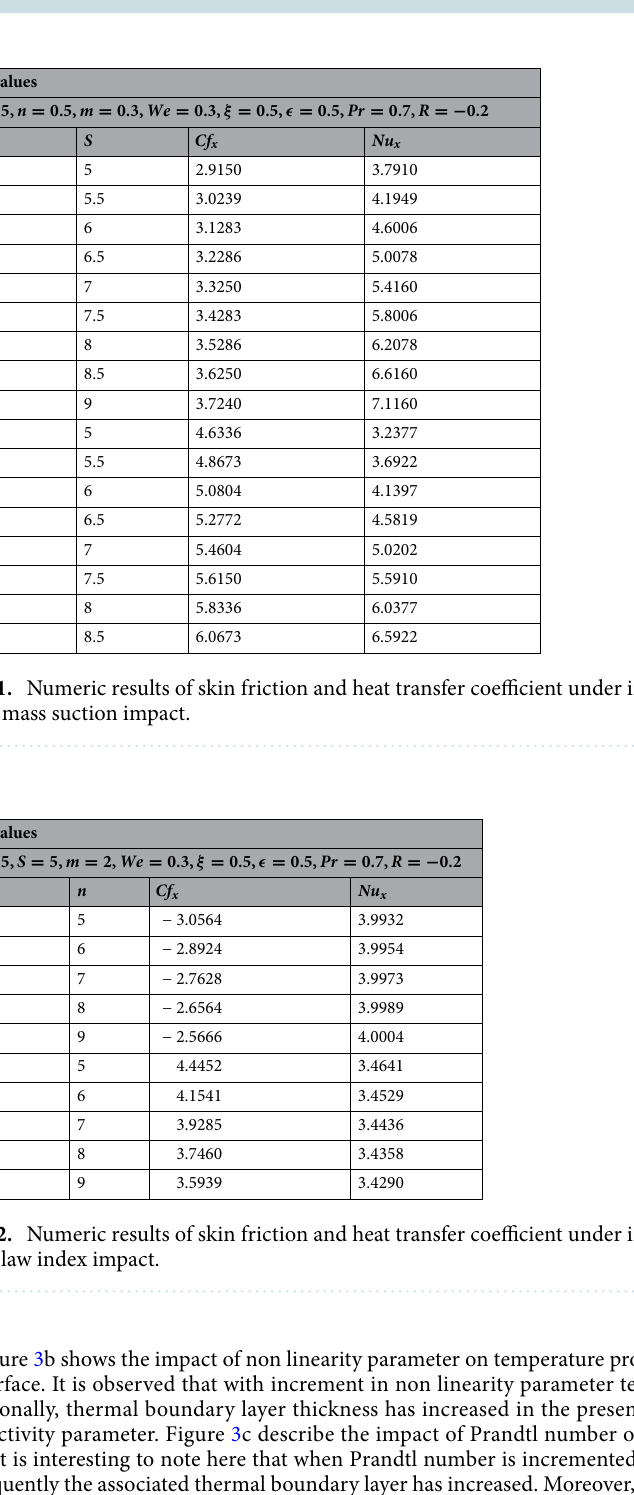
Figure 3b shows the impact of non linearity parameter on temperature profile of Carreau fluid over stretch- ing surface. It is observed that with increment in non linearity parameter temperature profile has decreased. Additionally, thermal boundary layer thickness has increased in the presence of high viscosity and thermal conductivity parameter. Figure 3c describe the impact of Prandtl number on temperature profile of Carreau fluid. It is interesting to note here that when Prandtl number is incremented the temperature profile enhance consequently the associated thermal boundary layer has increased. Moreover, it is discovered that with variable viscosity and thermal conductivity the temperature profile has increased under Prandtl number increment. Figure 3d discuss impact of variable viscosity parameter on temperature profile of Carreau fluid. When viscosity of Carreau fluid is increment as a result the thickness of boundary layer increase which consequently decline the associated motion profile and temperature profile. It is worth mentioning here that with increment in viscosity of Carreau fluid thermal boundary layer of fluid contracted due to reduction in thickness of boundary layer. Figure 4a,b discuss concentration profile of Carreau fluid under influence of Lewis number and chemical reaction parameters, respectively. Concentration profile under incremental change in Lewis number has sharply decreased. As a result associated concentration boundary of Carreau fluid has shown rapid contraction (see Fig. 4a). Figure 4b demonstrate impact of chemical reaction parameter on concentration profile. Concentration profile has decreased with increment in chemical reaction parameter. It is worth noting here that concentration layer has expanded with increment in chemical reaction parameter.